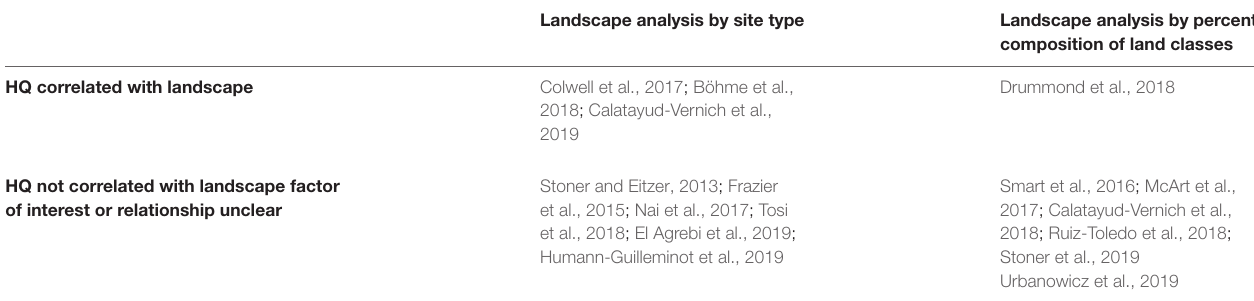
TABLE 3 | A table displaying how landscape context is used in HQ calculated from bee matrices.